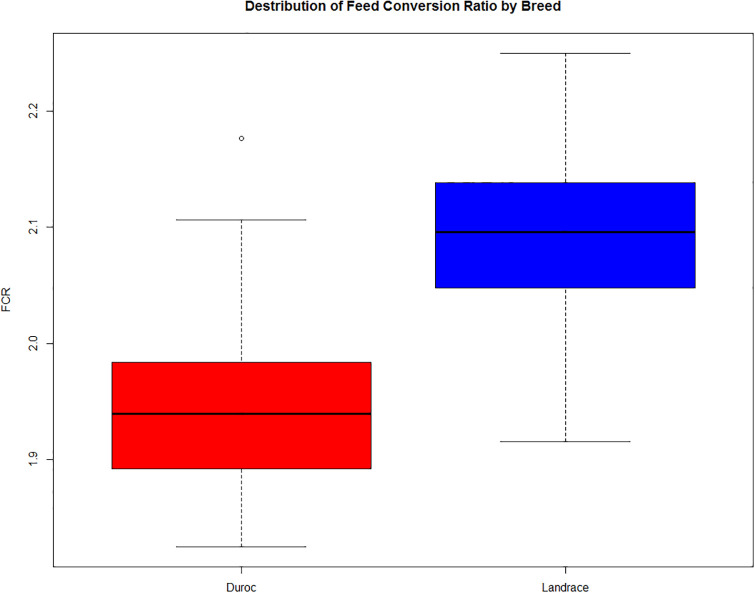
Distribution of FCR values in the two breeds.The Duroc pigs are generally more efficient, and thus have lower FCR on average.